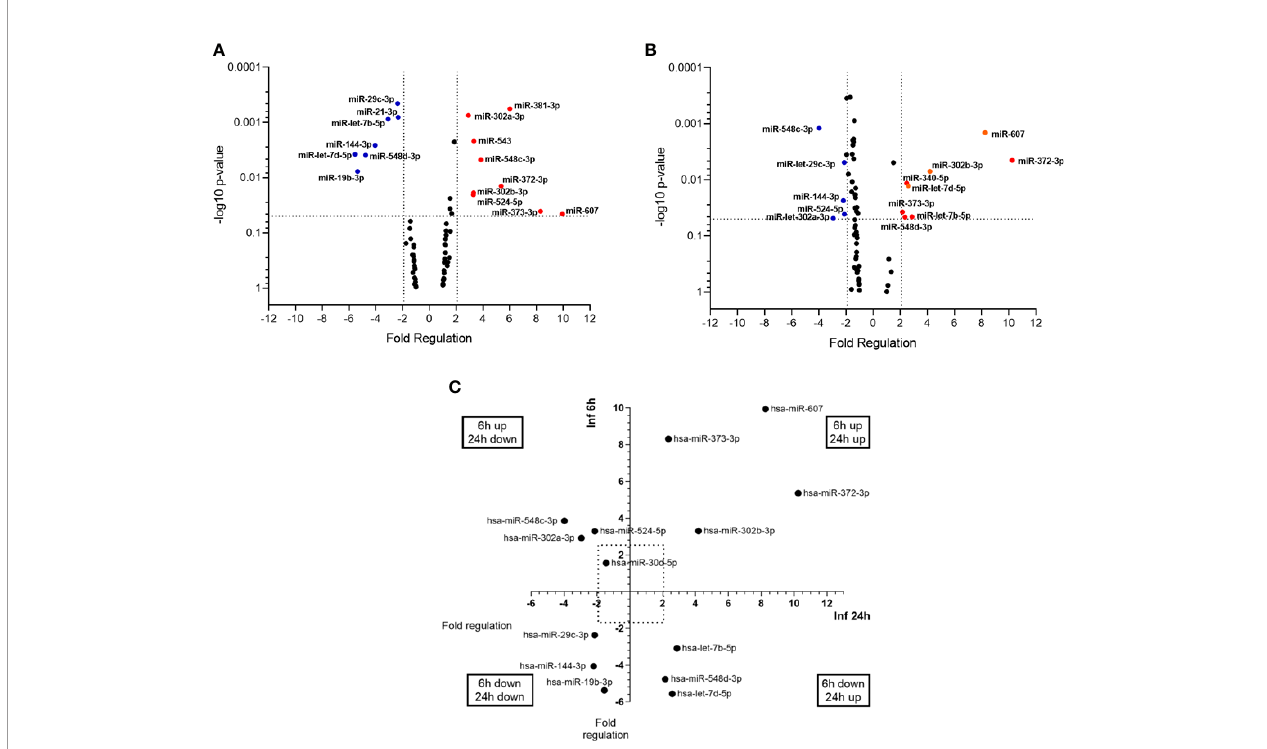
FIGURE 1 | miRNA pro fi les of L. (L.) infantum infected THP-1-macrophages. Volcano plot of differential expression of miRNAs in L. (L.) infantum promastigote- infected THP-1 macrophages compared to uninfected macrophages at 6h (A) and 24 h (B) post-infection. Each dot represents one miRNA. Red dots indicate up- regulated miRNAs, and blue dots represent downregulated ones (P < 0.05). The horizontal black dotted line corresponds to p=0.05, log 10. The relative up- and down-regulation of miRNAs, expressed as boundaries of 2 or -2 of Fold Regulation, respectively. P-value was determined based on a two-tailed Student ’ s t-test comparing the 6h p.i. or 24 h p.i. with uninfected macrophages. Signi fi cantly expressed miRNAs in different times distributed in four groups (C) . Results from three biological replicates developed in independent